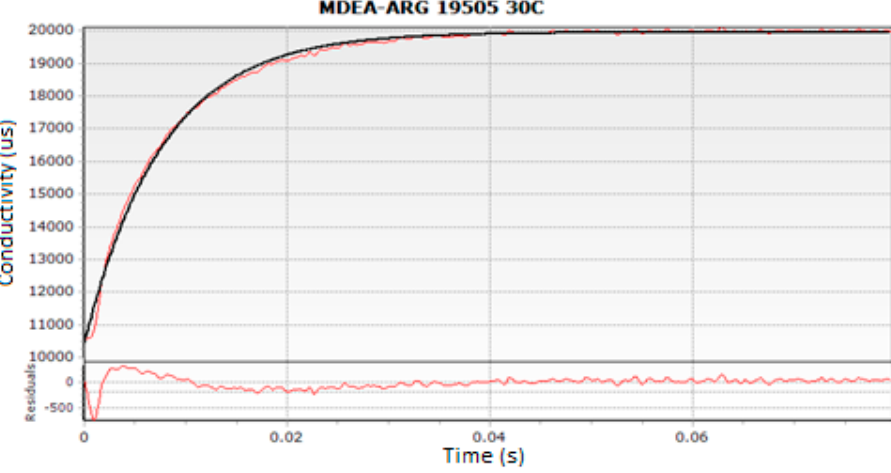
Figure 4. Typical Experimental run for MDEA-Arg at 303 K.